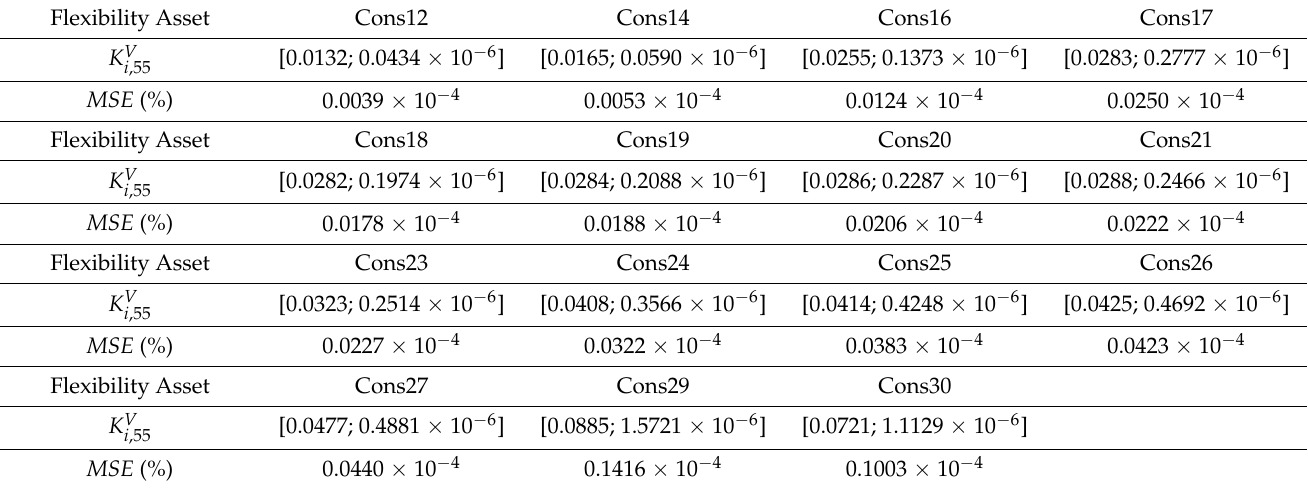
Table 3. Impact of change in active power consumption of flexibility provider/asset on change in voltage at a node with the smallest voltage for given grid condition.